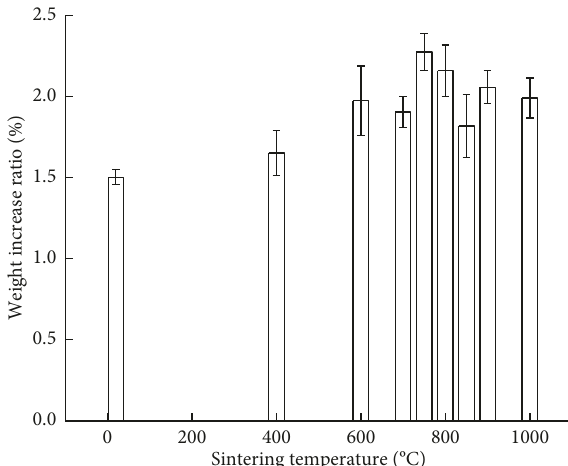
Figure 2: Loading content by heat treatment with different sin- tering